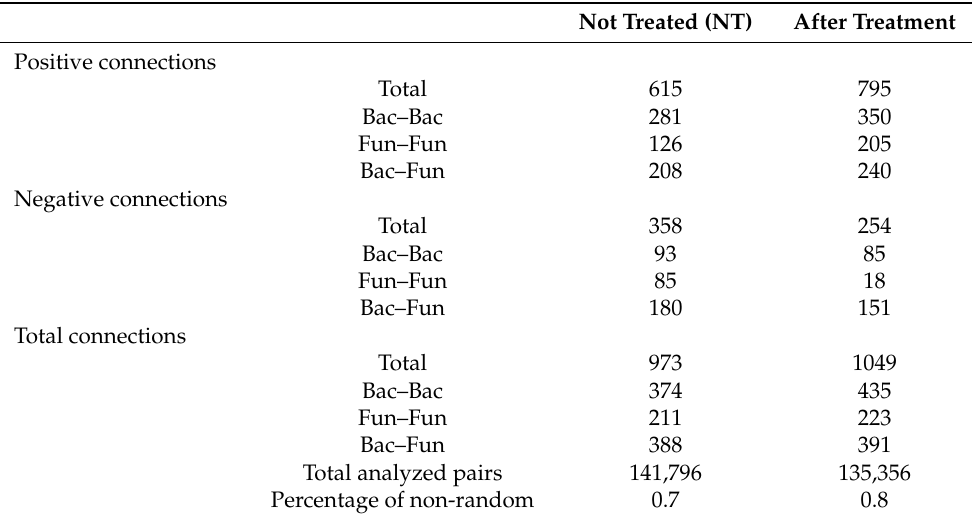
Figure 5. Significant co-occurrence networks of bulk soil bacterial and fungal communities of the Merlot vineyard before treatment application (13 March) ( A ) and after treatment application (16 June) ( B ). The nodes of each network are colored and shaped according to phylum affiliation. The edges connecting the nodes show negative (indicated with red lines) and positive (indicated with grey lines) associations between each species. Table 3. Degree of connection for bacterial and fungal communities found in Merlot vineyard plots before (not treated, NT) and after treatments, different irrigation amounts (FI, fully irrigated, or HI, half irrigated), and AMF inoculation (I, inoculated, or NI,